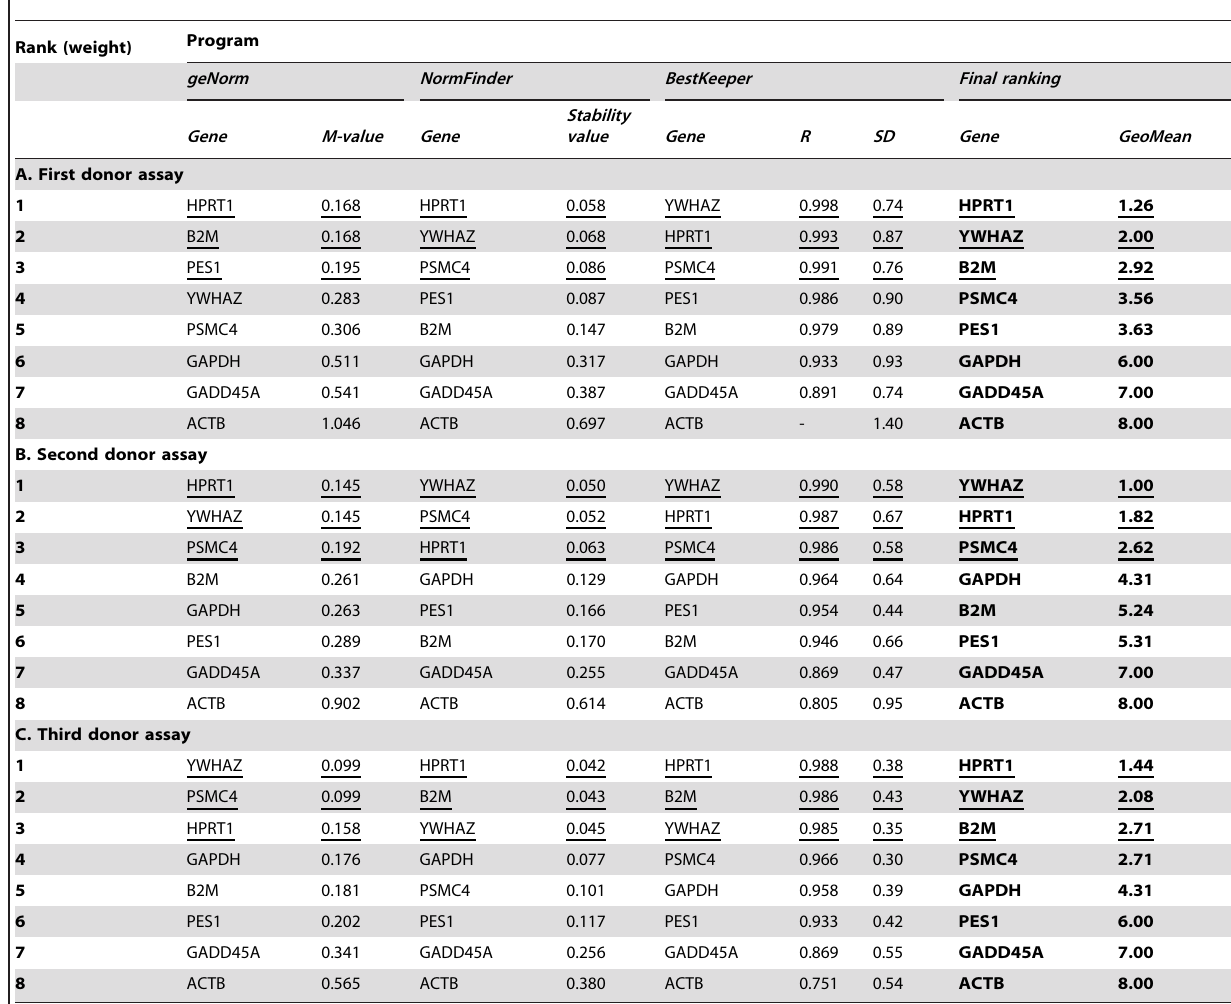
Table 4. Overall comparison of putative reference genes’ stability for statin-treated cells.